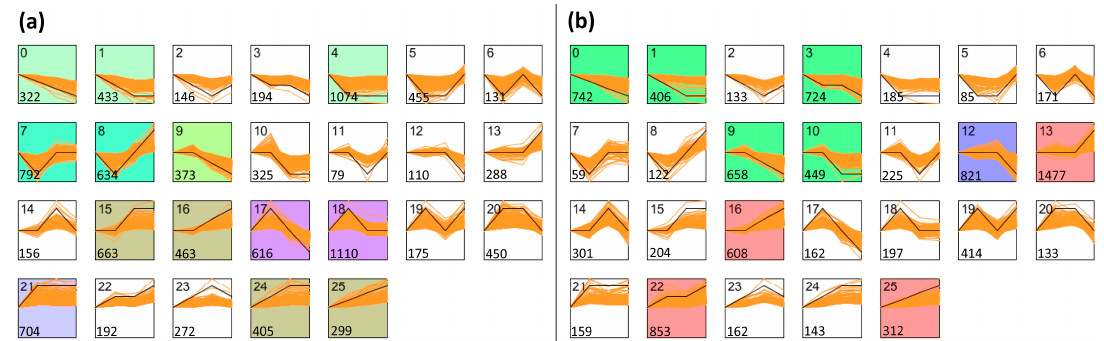
Figure 6. Co-expression patterns of genes of two poplar sections: ( a ) the co-expression patterns of genes for Aig; and ( b ) the co-expression patterns of genes for Leuce Duby (Leu). Co-expression analysis was finished using STEM software [29] with inputting log 2 (FPKM + 1) data of all genes of two poplars. Orange lines represented the expression patterns of genes. Black lines represented the expression model of clusters. Clusters were remarked by numbers on the top left corner in profiles. Number on the bottom left corner of a profile show the number of included genes in the profile. The colorized graphs have significances less than p -value 0.05. Non-white profiles of the same color represent profiles grouped into a single cluster.